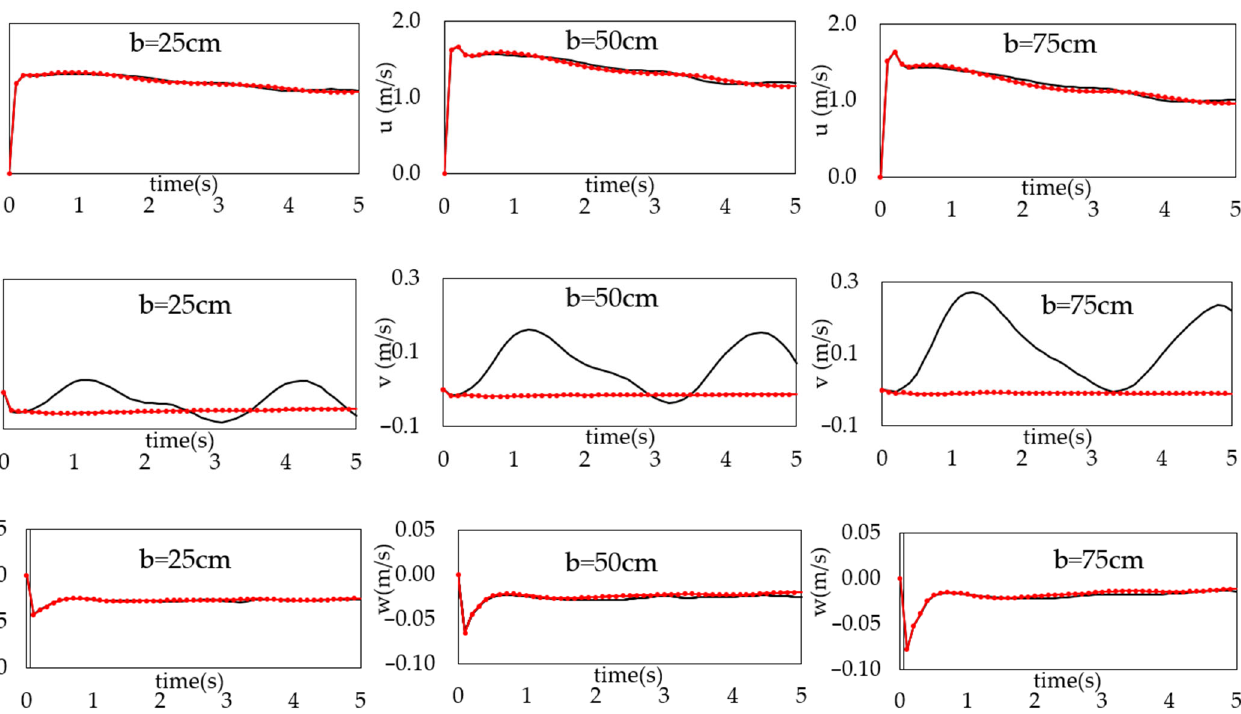
Figure 9. Water depth profiles at the center of dam gate. Solid line: cases 7A, 8A, 9A; dot line: cases 7B, 8B, 9B.